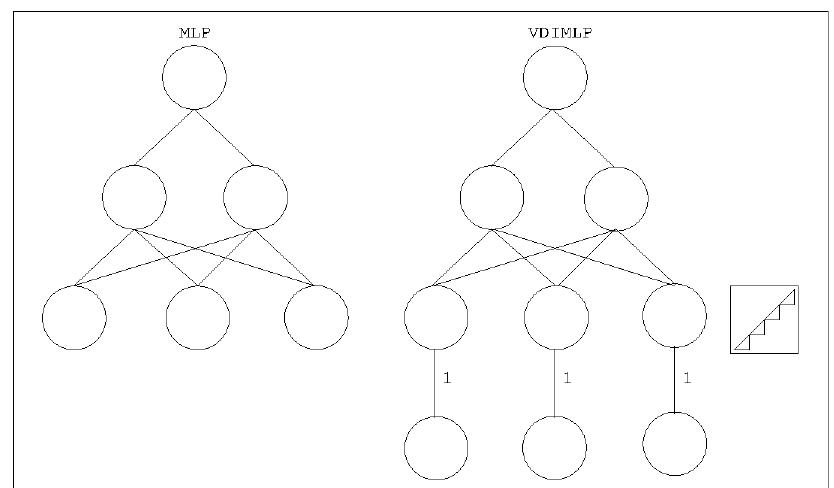
Figure 1. The concept of multi-layer erceptron (MLP) approximation by virtual discretized interpretable multi-layer perceptron (VDIMLP) networks, with MLP as a subnetwork of VDIMLP. The weight values of the two networks are equal from the first hidden layer of VDIMLP. Between the input layer and the first hidden layer, VDIMLP approximates the Identity function with a staircase activation function.